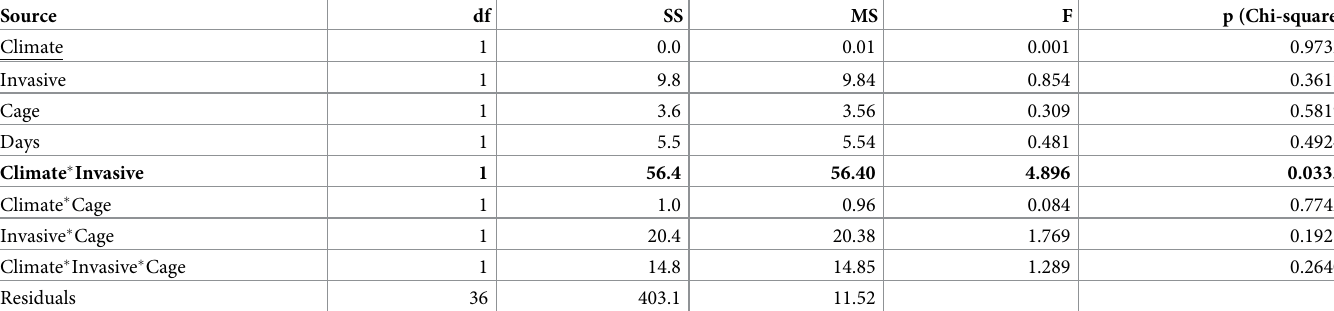
Table 2. Analysis of covariance for absolute relative growth (proportion of initial length) of Pacific chorus frogs.